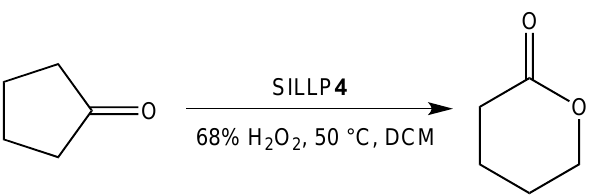
Figure 11. Brønsted-type SILLP based on silica material in Bayer – Villiger oxidation.